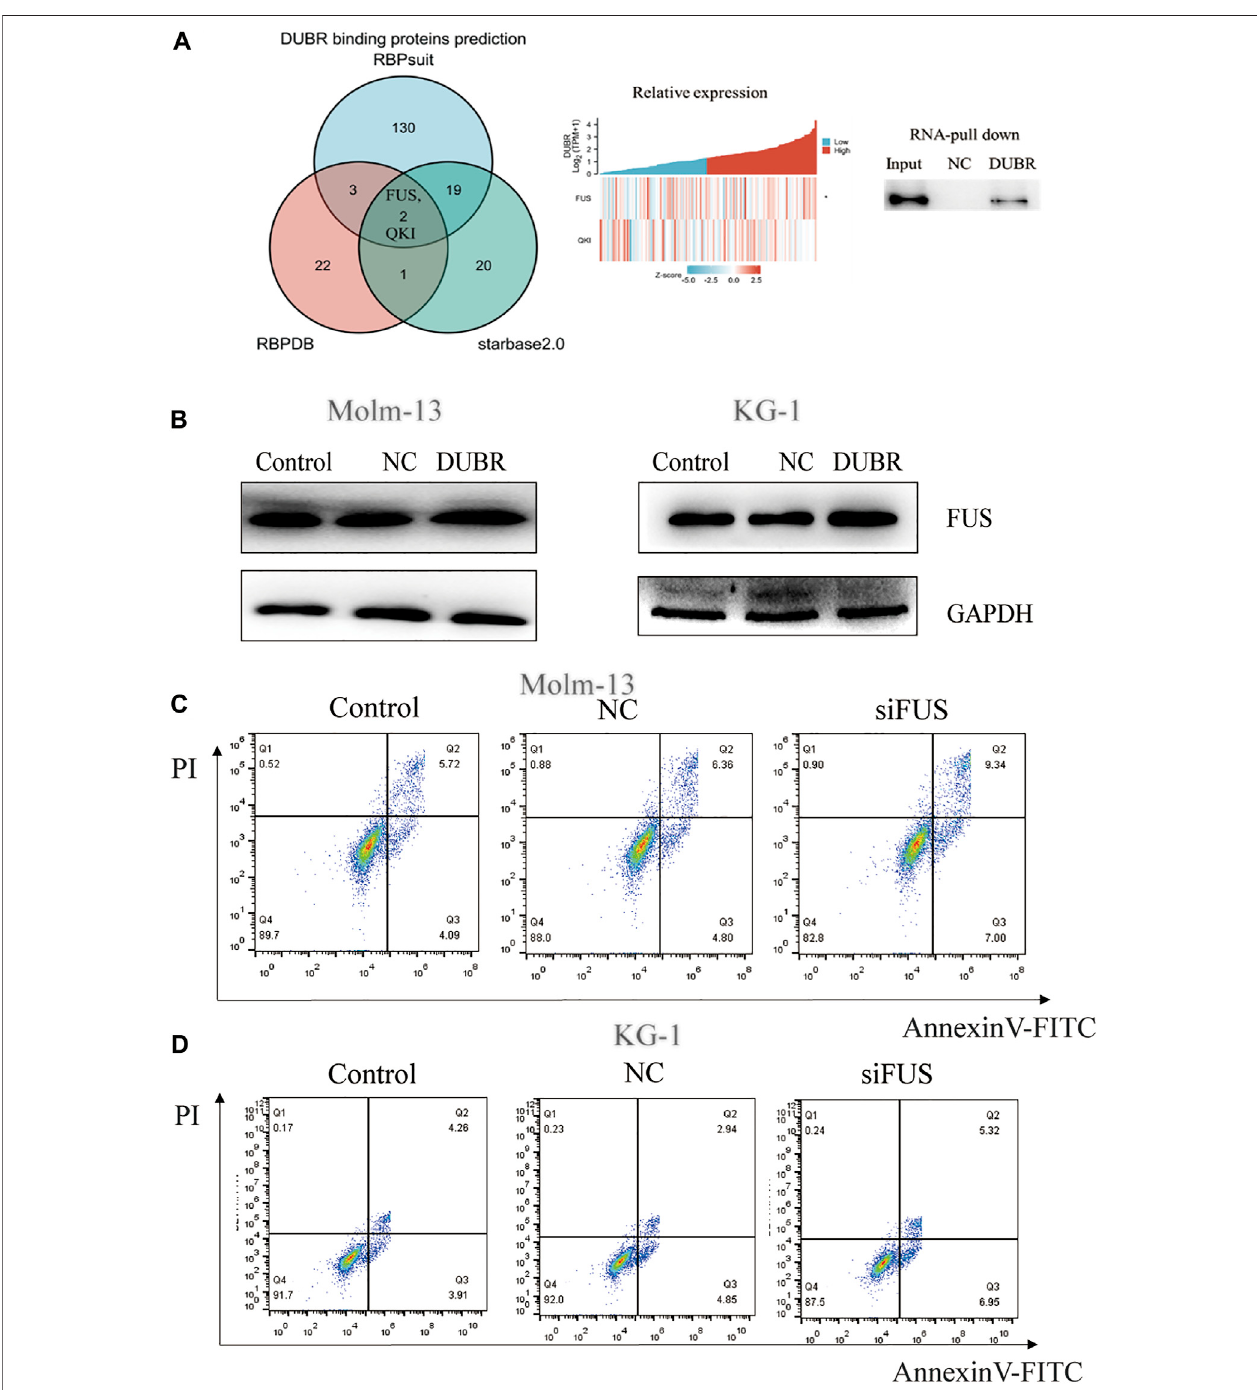
FIGURE6| DUBR bindstoFUSproteininAML. (A) Starbase2.0,RBPDB,andRBPsuitonlinewereadoptedforpredictingtherelationsoflncRNA DUBR withFUS protein (Left). Pearson correlation analysis on the relative expression between FUS and DUBR within AML bone marrow, p < 0.05 (Middle) . Binding of DUBR and FUS wasvalidated via RNA pull-down assay (Right) . (B) DUBR promotes FUS protein expression in AML. DUBR wasknocked in via transfection with DUBR plasmid, and in Molm-13andKG-1cells, DUBR promotedFUSexpression inAML.FUSknockdowninducedAMLcellapoptosis.FUSeffectontheapoptosisofMolm-13 (C) and KG-1 cells (D) was evaluated by fl ow cytometric analysis.